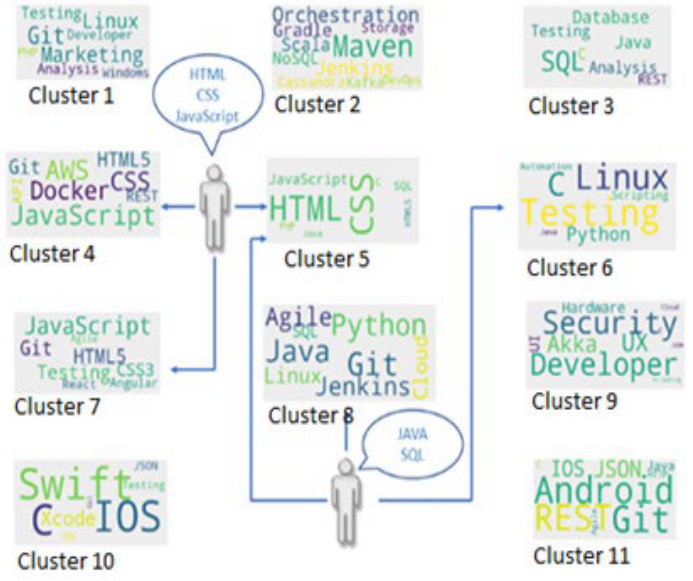
Figure 2. Clustering results [28].